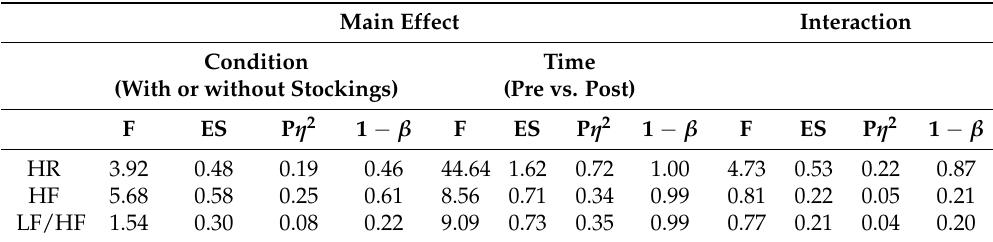
Table 3. Summarized results of statistical analysis for heart rate variability.